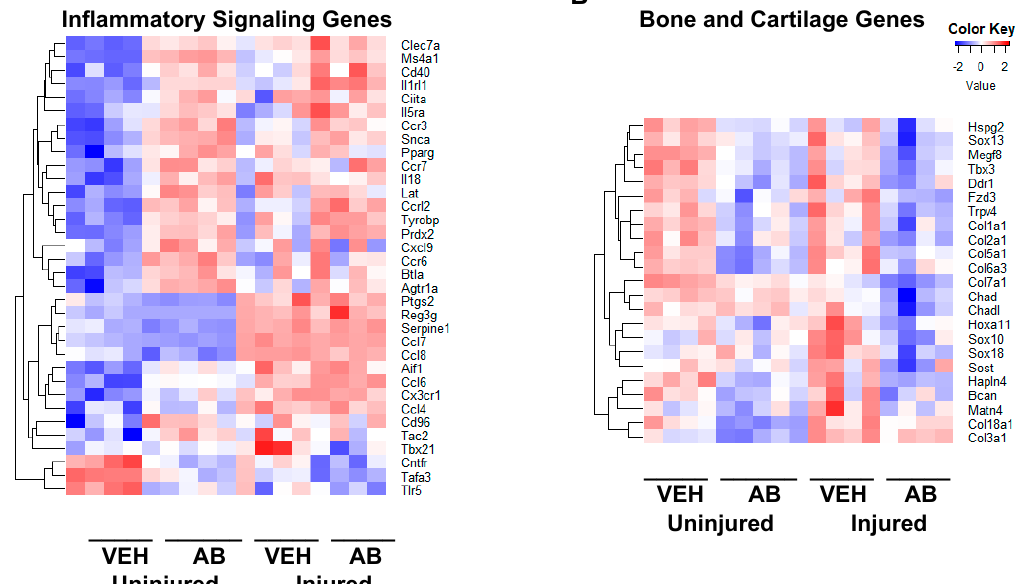
Figure 5. Gene expression changes associated with antibiotic treatment. ( A ) Genes associated with inflammatory process modified by AB treatment and AB with injury compared to VEH uninjured and injured. ( B ) Genes associated with bone and cartilage formation modified by AB treatment along with injury compared to VEH uninjured and injured.